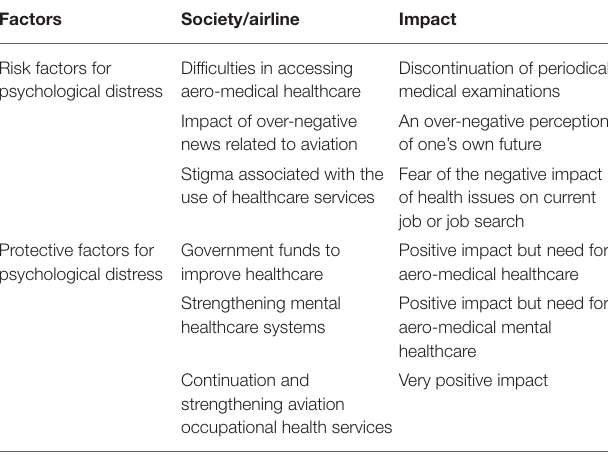
TABLE 1 | Factors related to aero-medical mental healthcare during